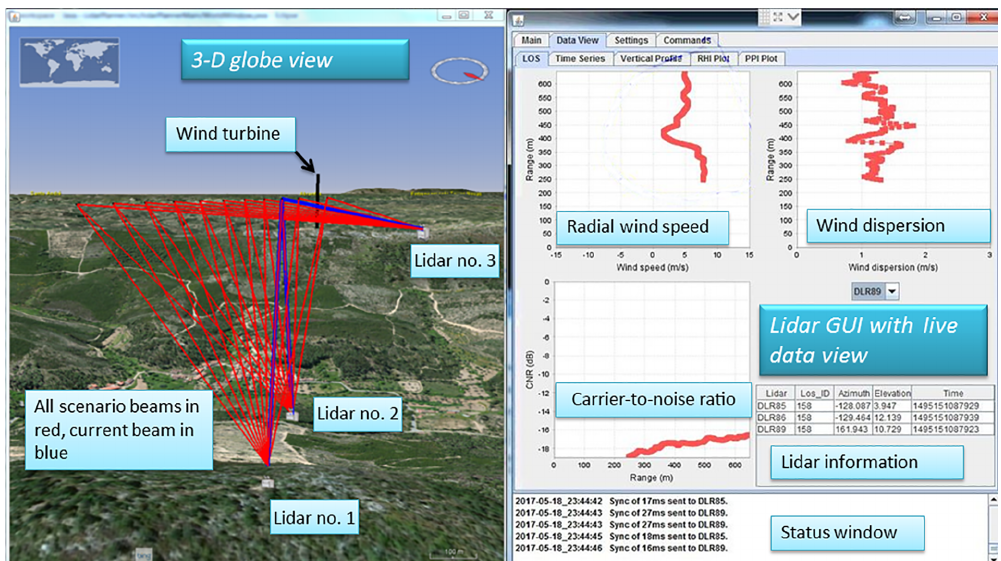
Figure 3. Example view of lidar planner software. On the left, the virtual globe with display of lidars and scanning scenario. On the right, the graphical user interface (GUI) for live data view. Other tabs in the program allow changing settings of the scenario, configuring the automatic scenario adaption etc.